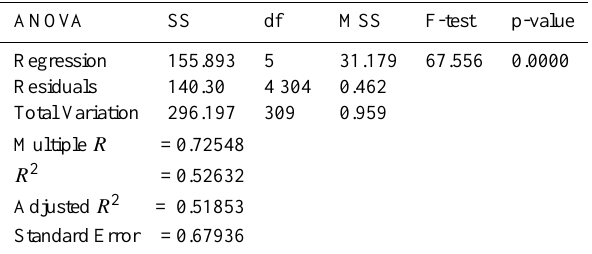
Fig. 7. Output of the regression algorithm (in red) and the original MMI data (in blue) for the 310 considered data